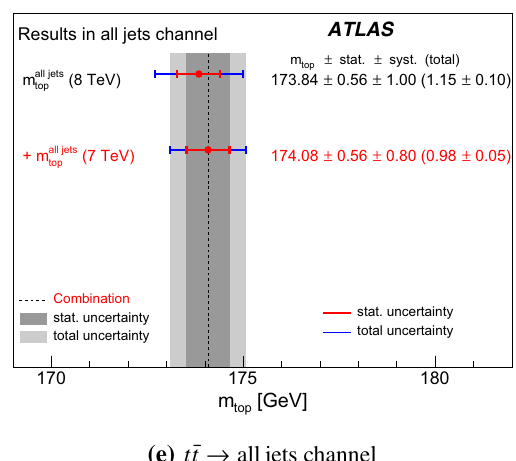
tainty, the total uncertainty and the uncertainty in the total uncertainty, which is statistical. a and b refer to the independent combinations of the three measurements per centre-of-mass energy resulting in uncor- related results m 7TeV top and m 8TeV top . c – e refer to the combination of the three correlated observables from pairs of measurements per t ¯ t decay (cid:3) + jets m alljets channel, resulting in m dilepton top , m top and